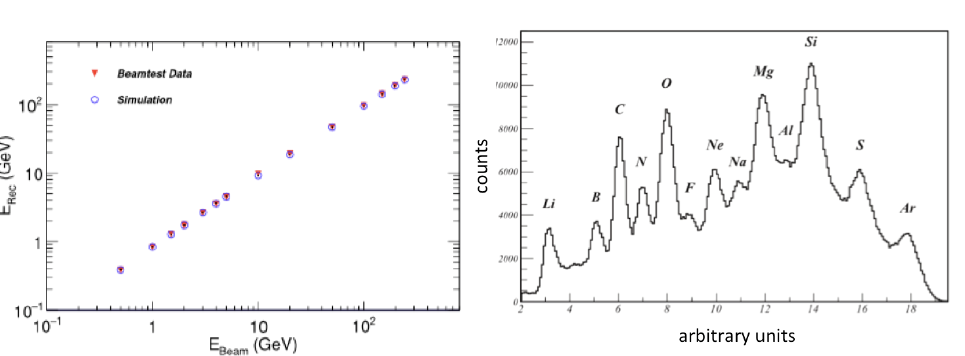
Figure 2. Beam test - Reconstructed energy versus electron beam energy.